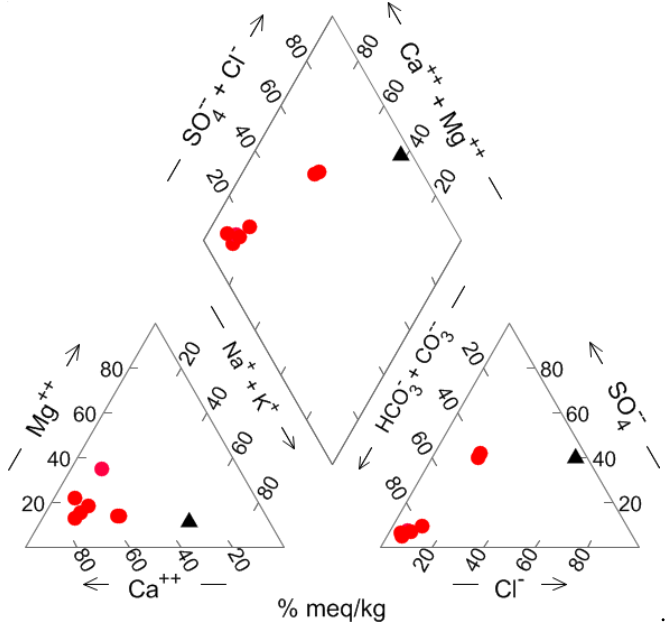
Figure 4. Piper diagram for groundwater samples. Red circles: FB_1W to FB_6W wells and piezom- eter; black filled triangle: deep water (see text). Table 3. The physico-chemical parameters and major ions chemistry (mg/L) measured on ground- water.